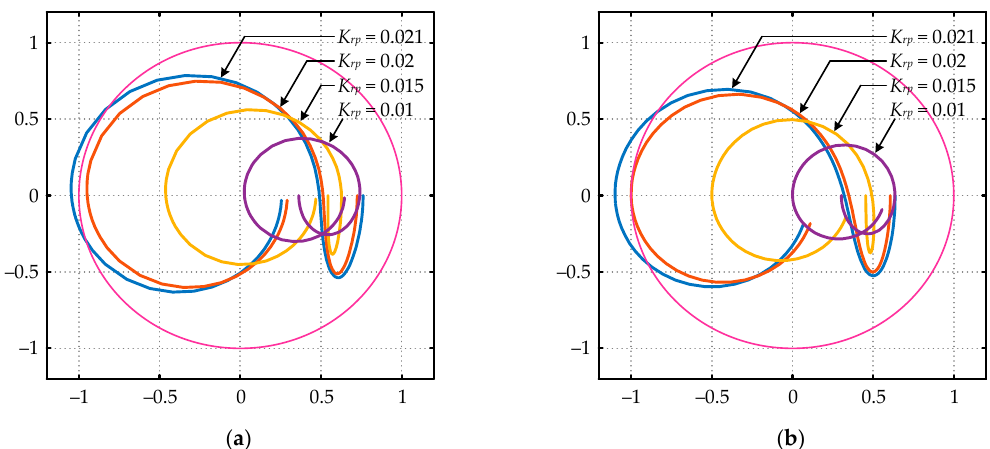
Figure 9. Root trajectories of H ( z ): ( a ) Buck mode; ( b ) Boost mode. Energies 2018 , 11 , x FOR PEER REVIEW